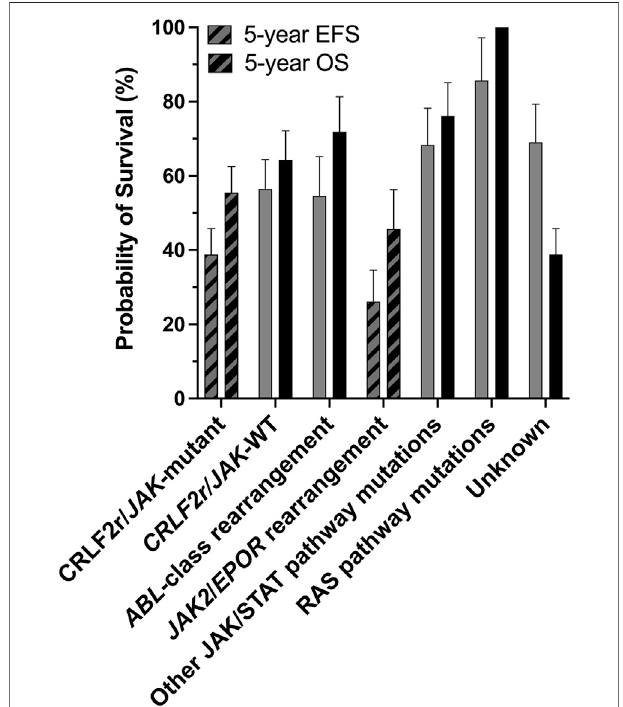
FIGURE1| The CRLF2 r/ JAK -mutantand JAK2 / EPOR rsubtypesofPh- like ALL are associated with poor outcomes. Outcome analyses for different genomic subtypes of Ph-like ALL for all ages combined, probabilities of 5- yearsevent-free survival(EFS)and overallsurvival(OS)areshown.There are signi fi cant differences in the 5-years EFS and OS of CRLF2 r/ JAK -mutant and JAK2 / EPOR r cases compared with other Ph-like ALL subtypes. Figure adapted from Roberts et al.